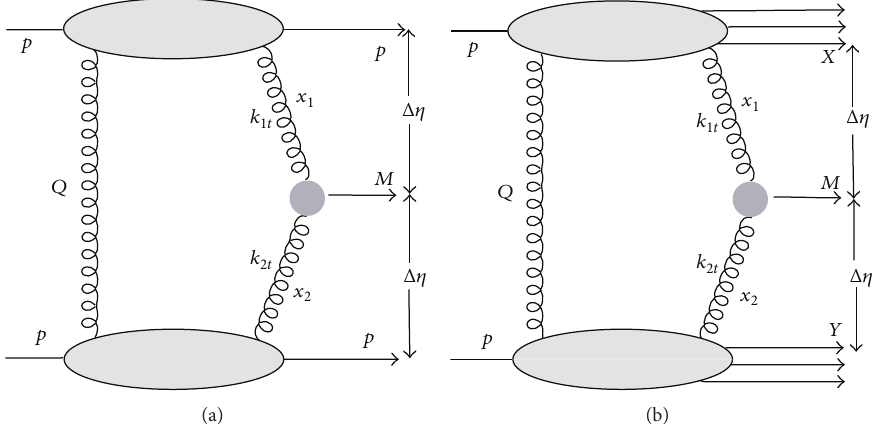
Figure 1: Double diffractive production of a system of mass 𝑀 with rapidity gap Δ𝜂 on either side via (a) the central exclusive process and (b) the central inclusive process at the